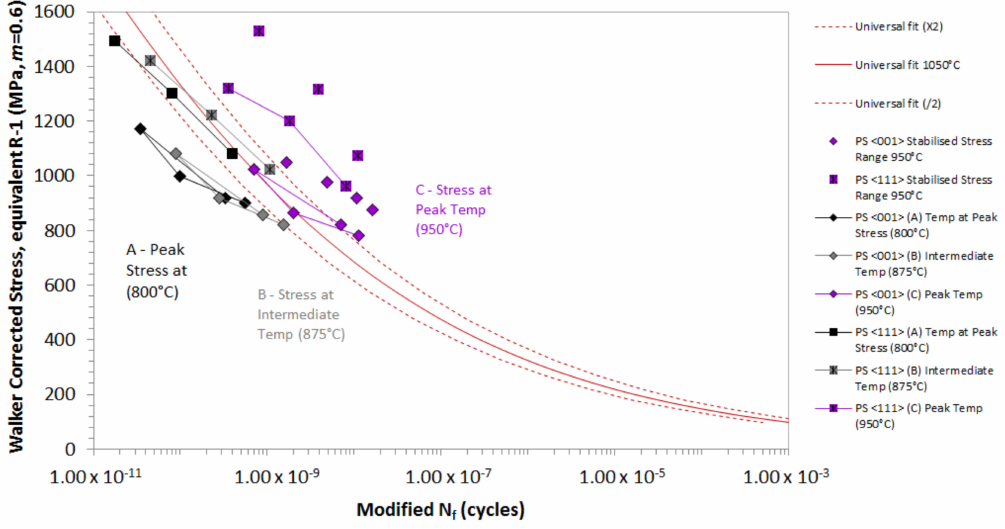
Figure 9. Illustration of how the different means of extracting the stress range for the 20 ◦ phase shift TMF correlate with the isothermal datum